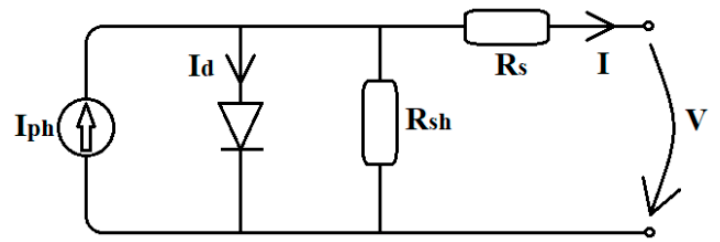
Figure 1. Photovoltaic equivalent single diode circuit.